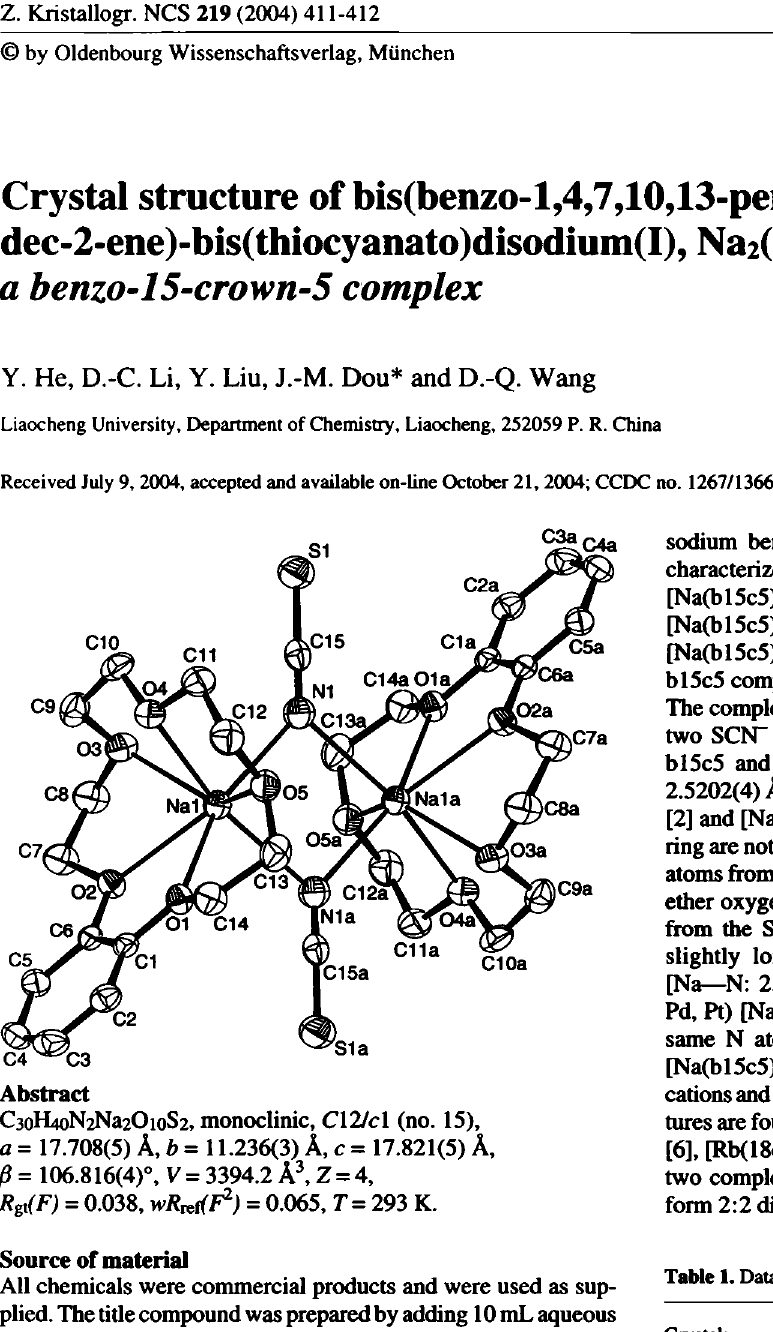
Table 1. Data collection and handling.